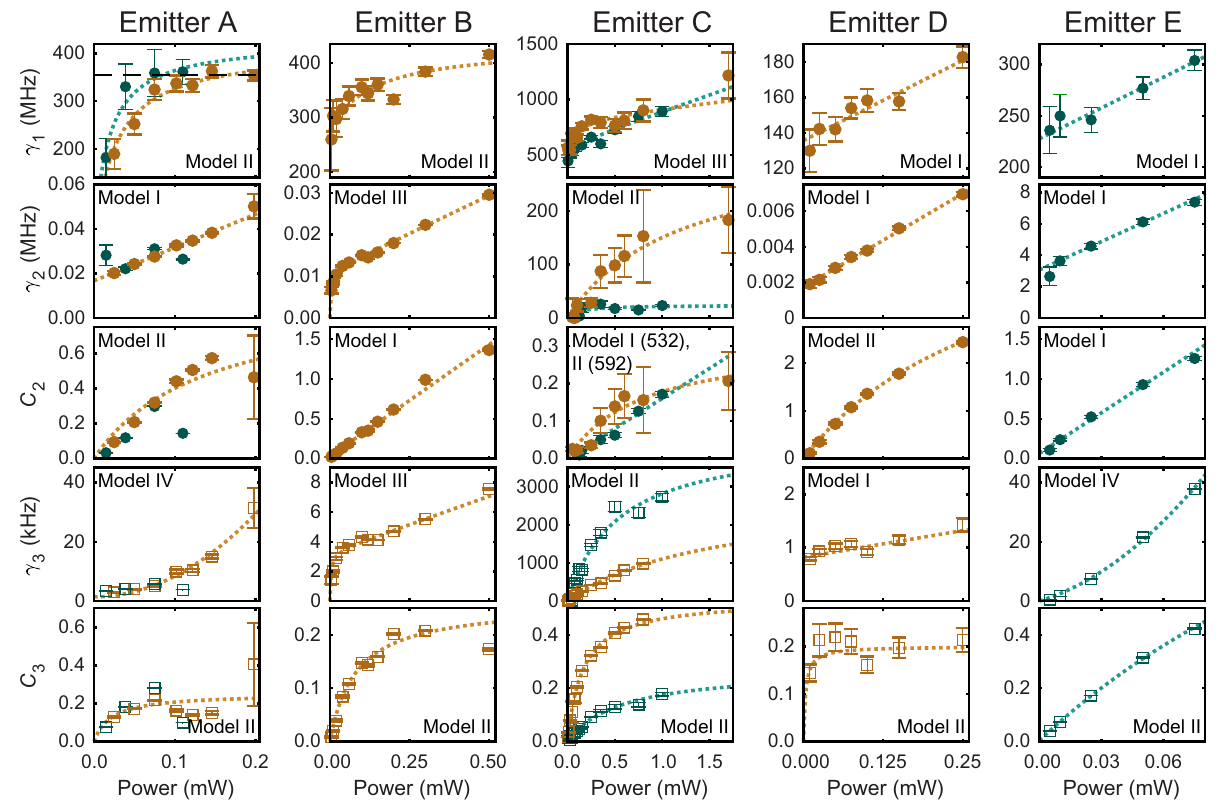
FIG. 5. Photon emission correlation spectroscopy. Excitation power and wavelength dependence of (row 1) the antibunching rate ( γ 1 ) denoted as circles, (row 2) the bunching rate ( γ 2 ) denoted as circles, (row 3) the bunching amplitude ( C 2 ) denoted as circles, (row 4) the bunching rate ( γ 3 ) denoted as squares, and (row 5) the bunching amplitude ( C 3 ) denoted as squares, of the five QEs presented in each column. The black dashed line in the upper-leftmost plot (QE A) represents the lifetime. Orange (green) data correspond to excitation at 592 nm (532 nm). The error bars represent one standard deviation. The dotted lines are fits to the metadata, as discussed in the